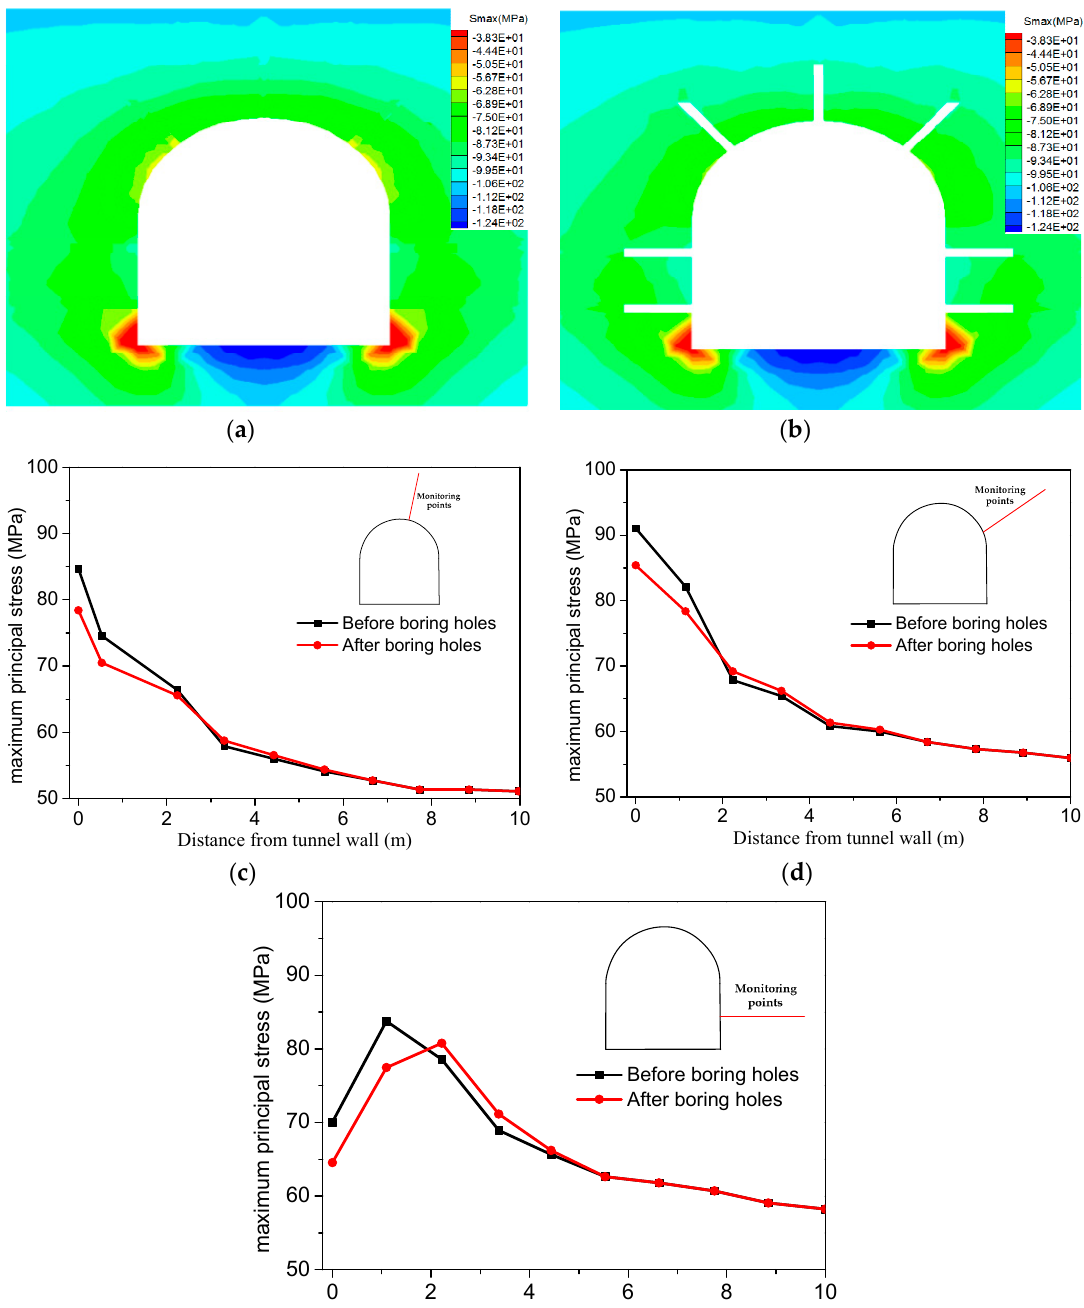
Figure 6. Displacement distribution of surrounding rock.